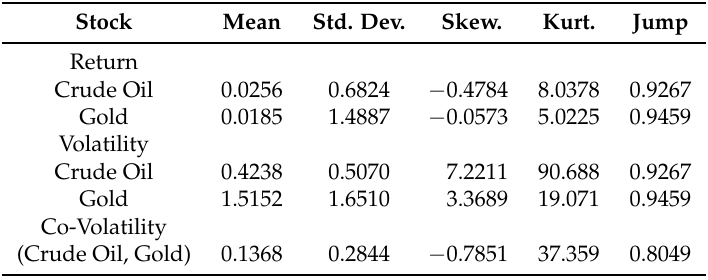
Table 1. Descriptive statistics of returns, volatility and